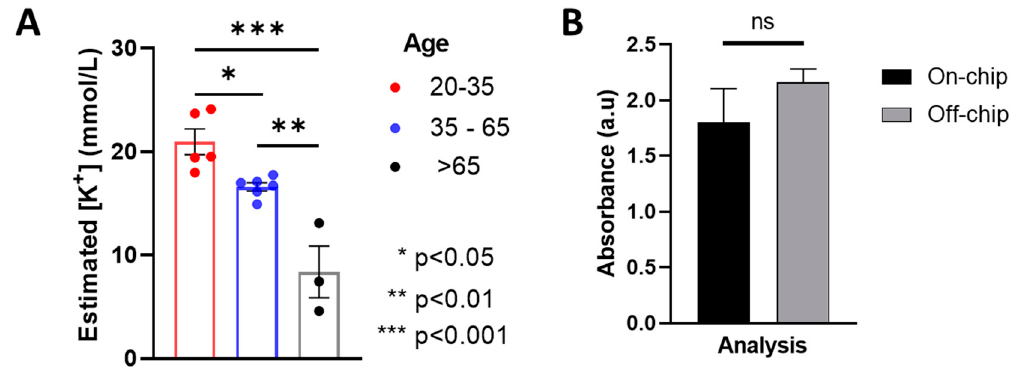
Figure 5. Results of the colorimetric optical absorbance detection of potassium from unstimulated whole saliva. ( A ) Measurement of estimated potassium concentration among people (15 volunteers) of different age groups indicating that older people (>65 y age) show a significantly lesser ( p < 0.01) salivary potassium content than people in the age group of 35–65; and also significantly reduced potassium than people in 20–35 age group. In general people above the age of 35 show significantly lesser ( p < 0.05) potassium than people under the age of 35. ( B ) Comparison of the optical absorbance values of salivary samples mixed with chromogenic agent measured on chip and off-chip (using an ultraviolet/visible (UV/Vis) spectrometer) shows no significant difference ( p = 0.2643 with paired t-test) for the samples analyzed through the two measurement techniques.